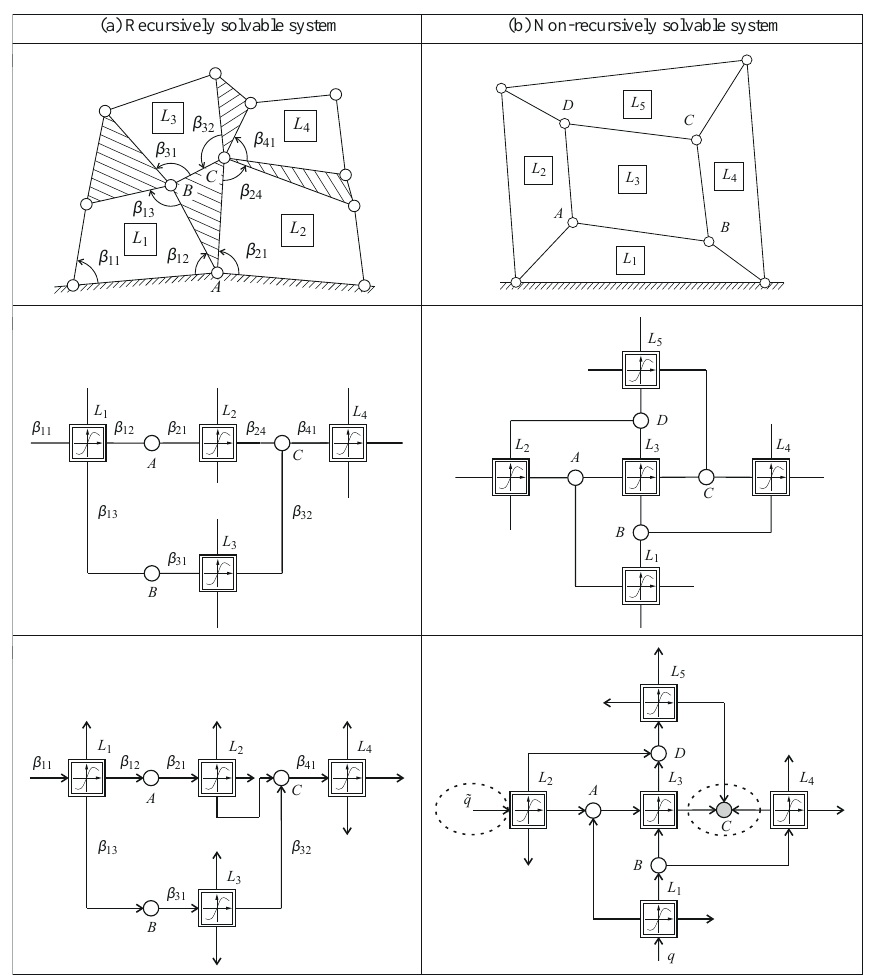
Figure 3. Mapping of mechanisms to kinematical